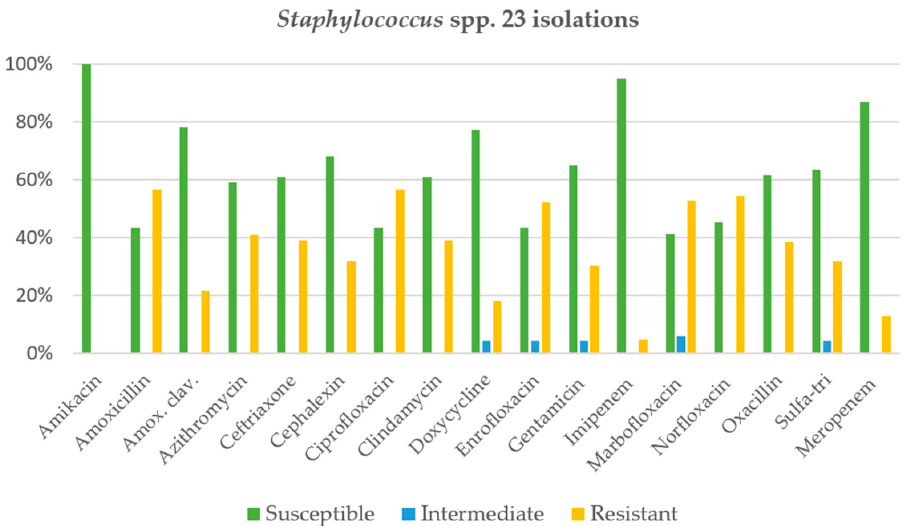
Figure 4. Activity of antimicrobials against Staphylococcus spp. in 23 isolations.